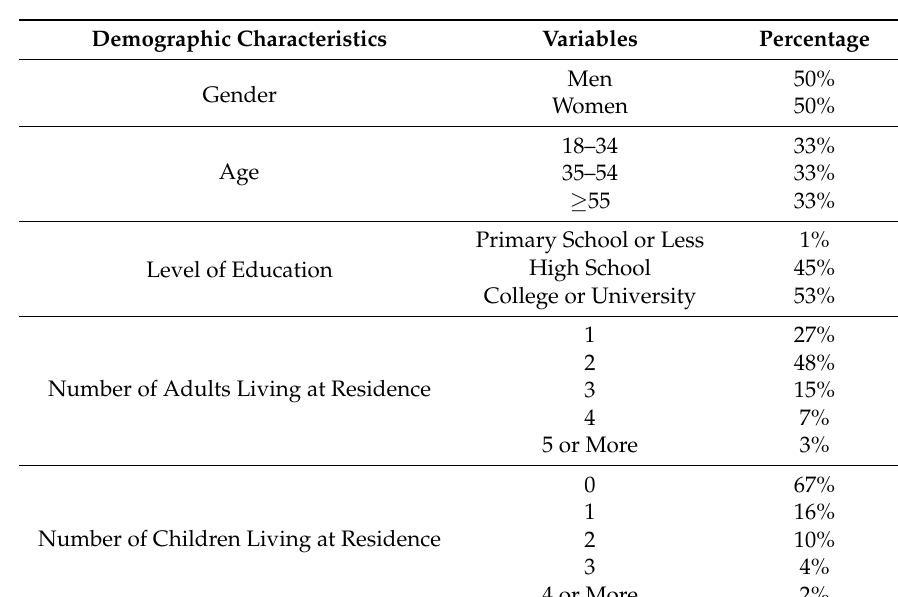
Table 1. Demographics Percentages